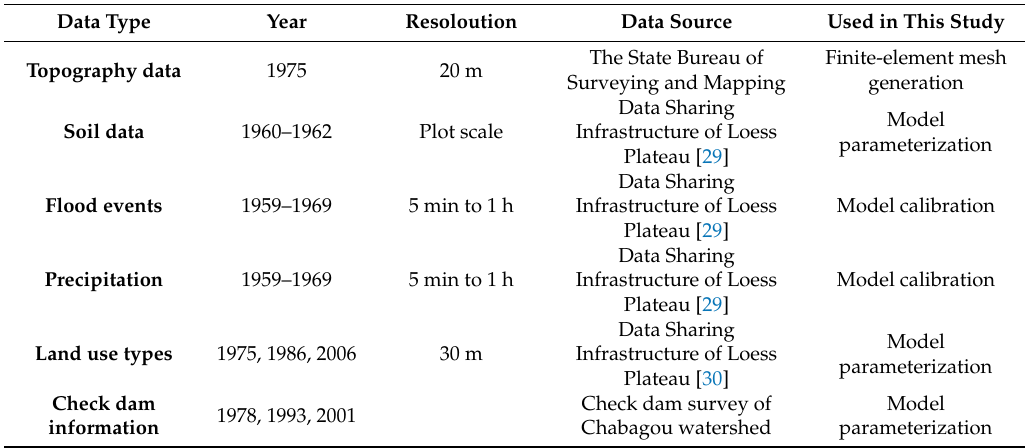
Table 1. Data set used in this